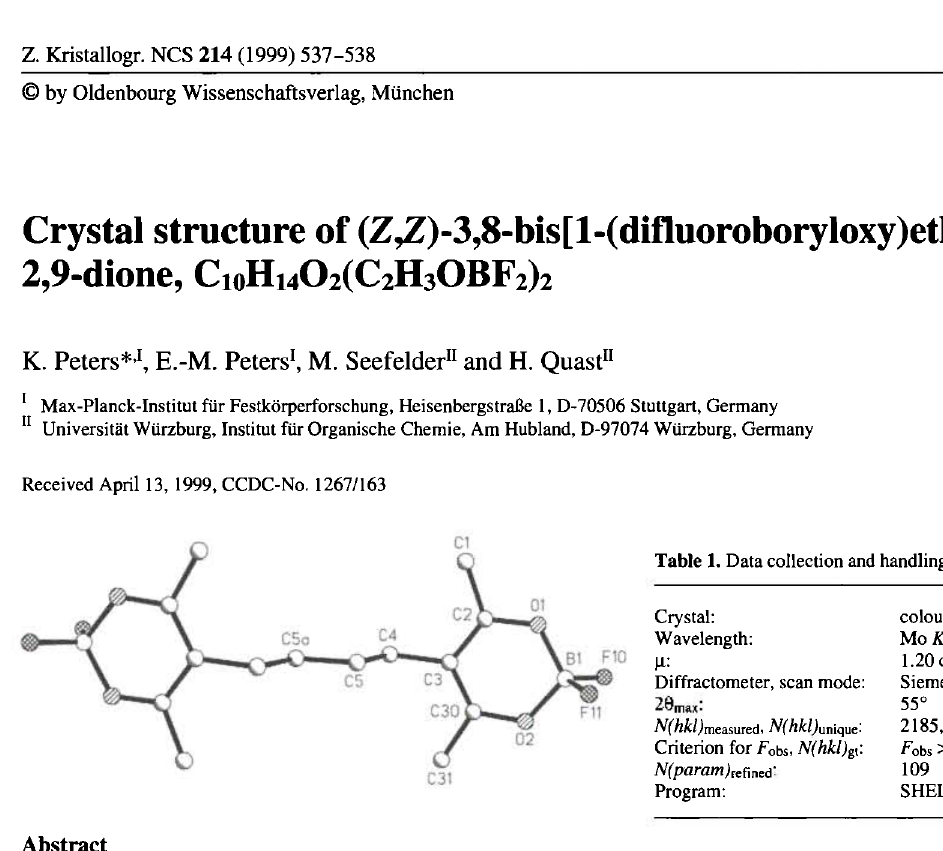
Table 2. Atomic coordinates and displacement parameters (in Ä 2 ).